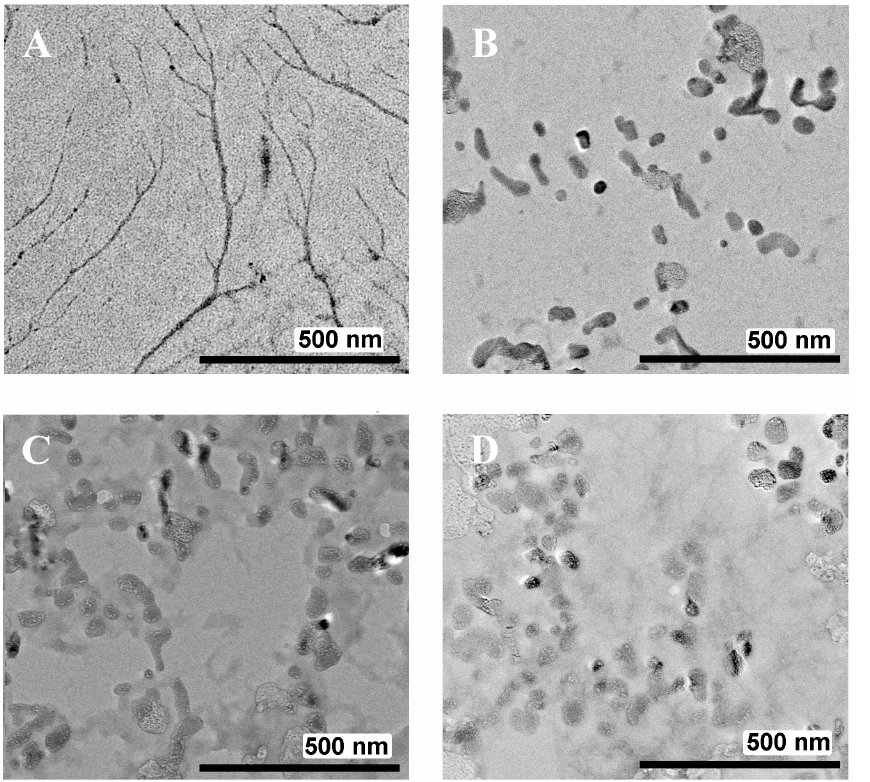
Figure 7. TEM images of CT-DNA ( A ), CT-DNA with 5 ( B ), CT-DNA with 6 ( C ), CT-DNA with 7 ( D ).